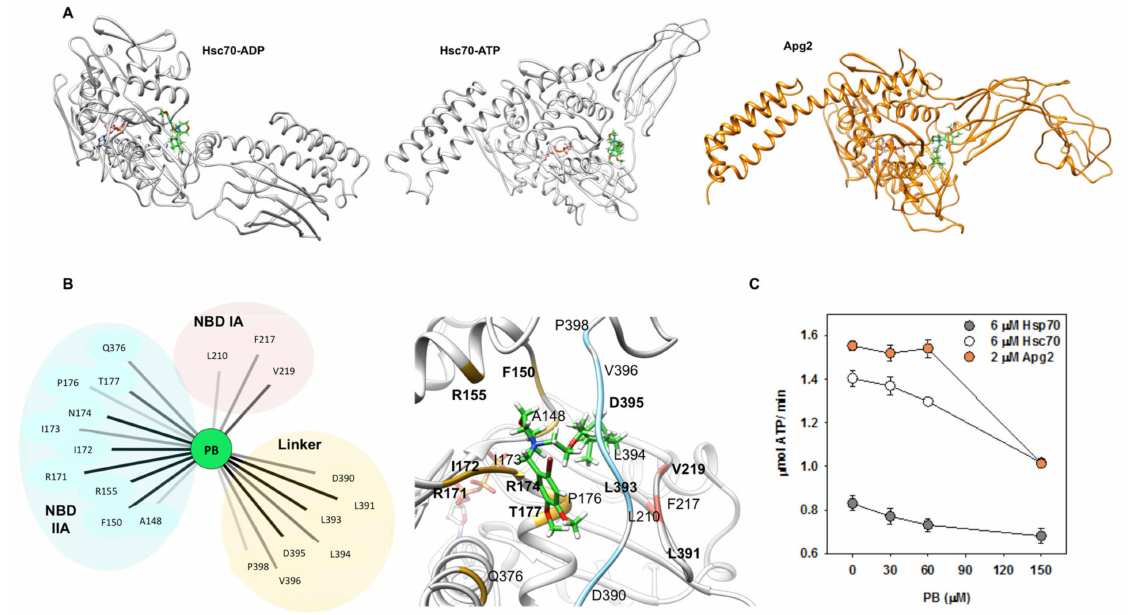
Figure 7. PB binds to Hsc70 and Apg2 through interactions with the NBD and the linker and impairs their ATPase activity. ( A ) Best docking results of PB (green) with Hsc70 in ADP and ATP states, and with Apg2. ( B ) Interactions between PB (green) and Hsc70-ATP (light grey) that allow the compound to be stable in the initial predicted binding pocket after a MD simulation of 100 ns. Interacting residues are grouped and colored depending on their location in the three-dimensional structure of the protein: IA subdomain of the NBD in pink, NBD IIA subdomain in yellow and the linker in blue. (Left panel) Interaction network between PB and Hsc70 in ATP state performed after analyzing the MD simulation of this complex using Cytoscape. Bold lines correspond to the most frequent and thus, the most stabilizing interactions. (Right panel) Representative frame of the PB-Hsc70 complex during the simulation. ( C ) Effect of PB on the ATPase activity of Apg2, Hsc70, and Hsp70. Increasing concentrations of the compound were added to 6 µ M Hsc70 (white), 6 µ M Hsp70 (grey), or 2 µ M Apg2 (orange). The ATPase activity of the chaperones showed a concentration-dependent inhibition in the presence of PB. Values are expressed as means ± SD obtained from three independent